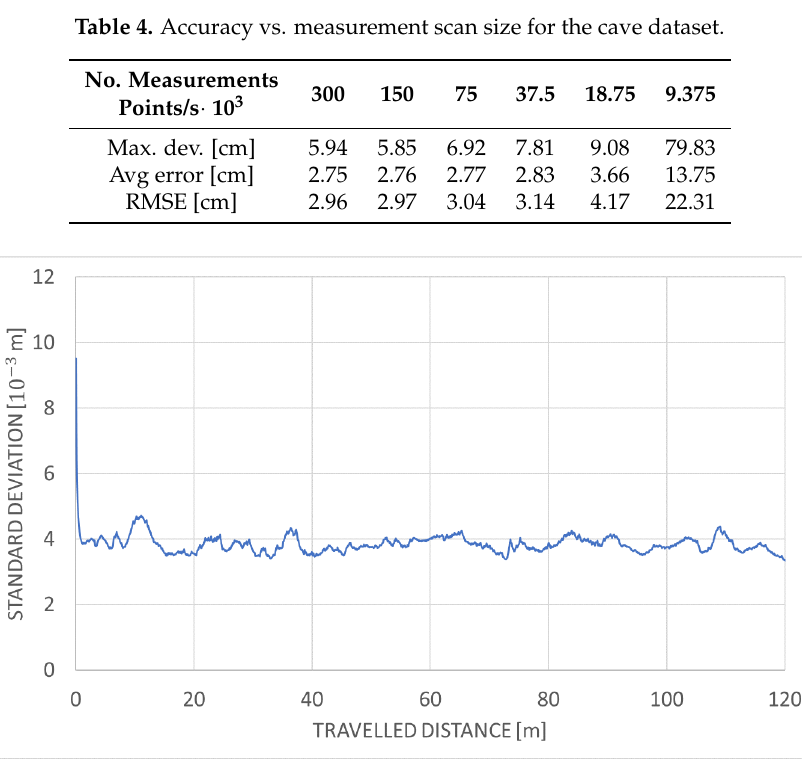
Figure 13. Standard deviation in function of travelled distance for parallel-serial algorithm and mine gallery test dataset.